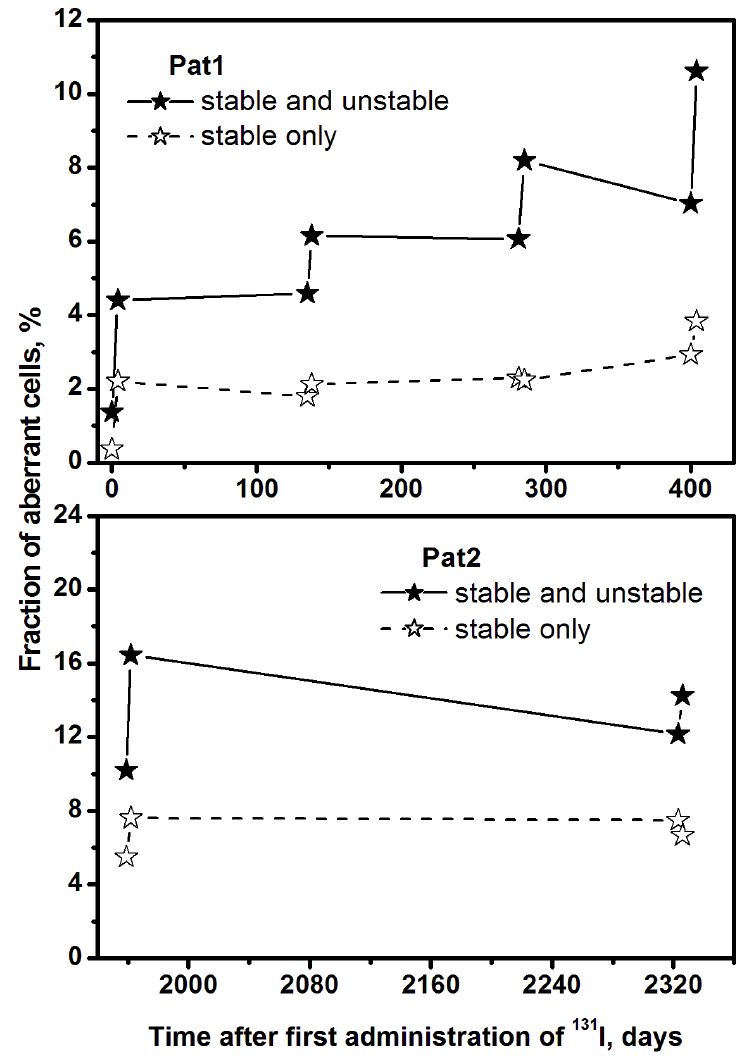
Figure 2. The fraction of aberrant cells detected by mFISH in examined patients. Asterisks indicate blood sampling before and after RIT (open symbols—percentage of stable aberrant cells; painted symbols—percentage of all aberrant cells).